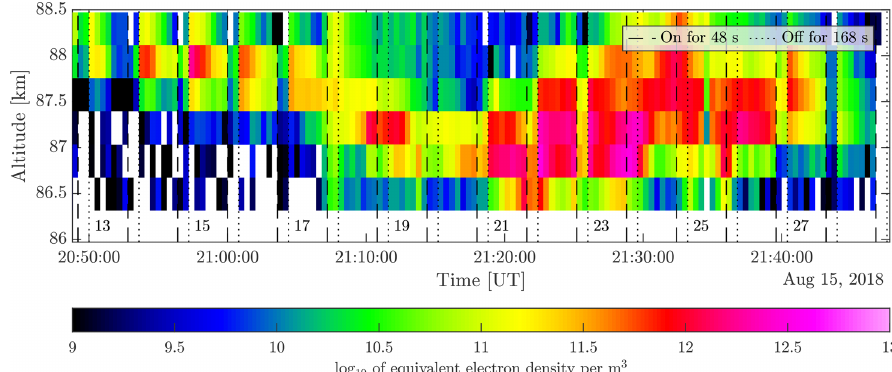
Figure 9. Backscattered power as a function of altitude and heating intervals observed during the night of 15/16 August 2018, in area 2.